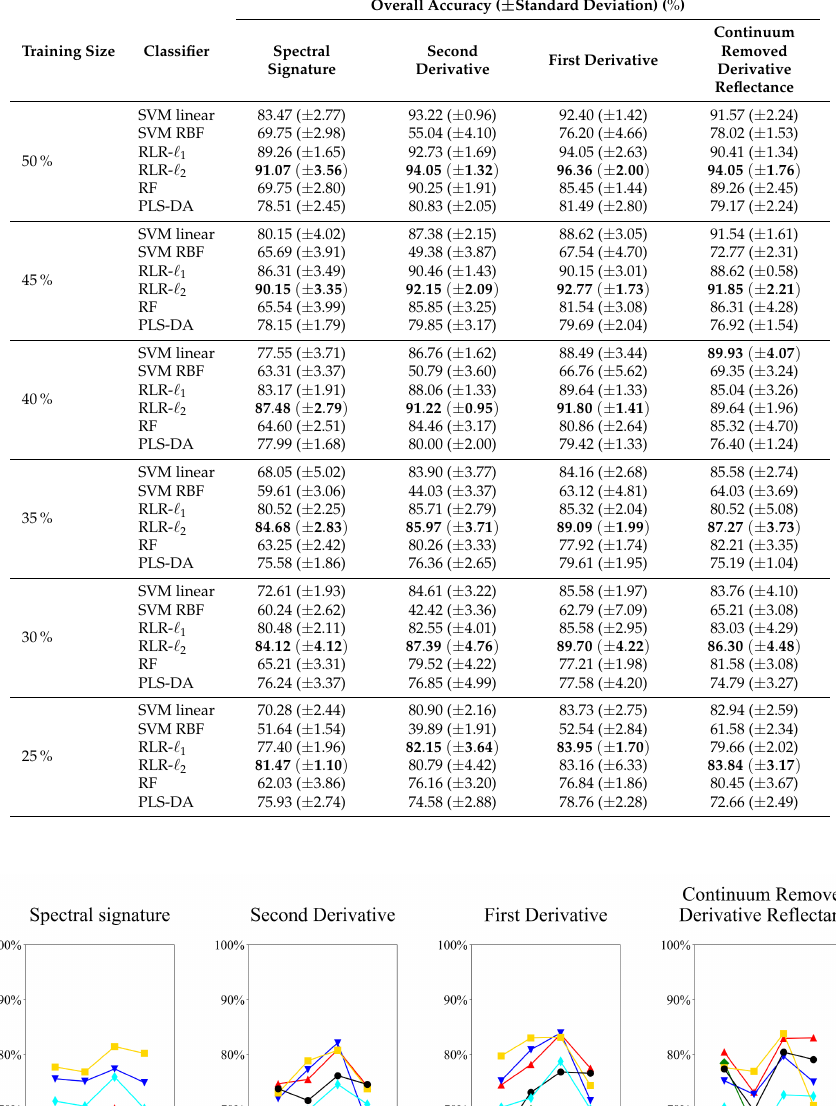
Table 19. Vegetation types identification accuracies (overall accuracy ( ± standard deviation) in %) in [350–1350 nm].